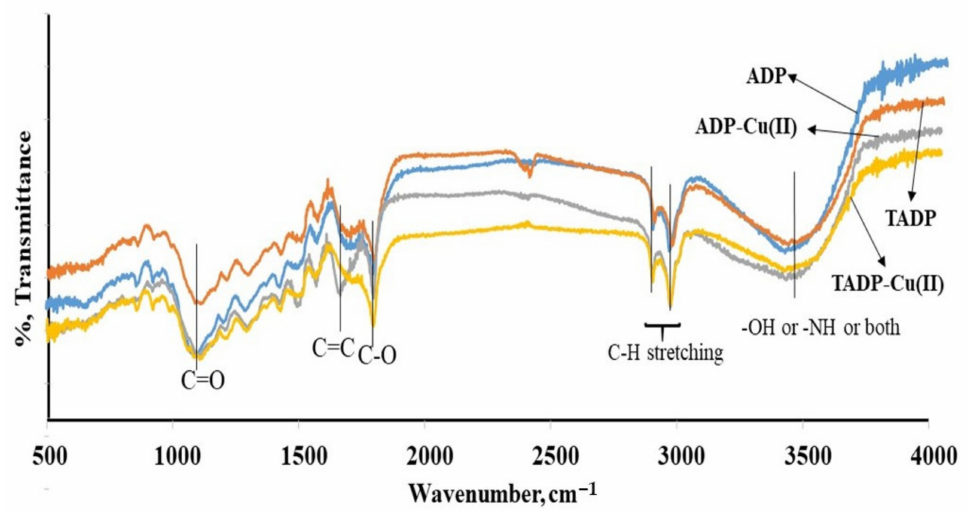
Figure 5. FT-IR analysis of ADP, ADP-Cu(II) ions, TADP, and TADP-Cu(II) ions (experimental conditions: initial conc. 25 mg/L; adsorbent weight 0.005 g; volume 0.05 L; temperature 25 ◦ C; contact time 5 h; shaker speed: 100